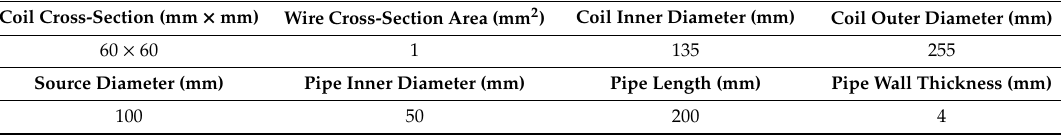
Table 1. Geometric parameters of the